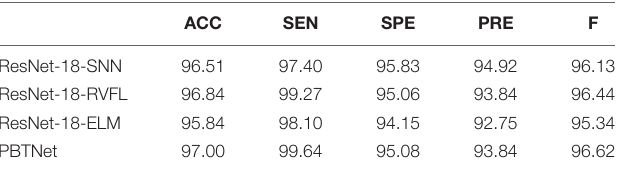
TABLE 6 | Comparison of the proposed models based on 5-fold cross-validation (unit: %). ACC SEN SPE